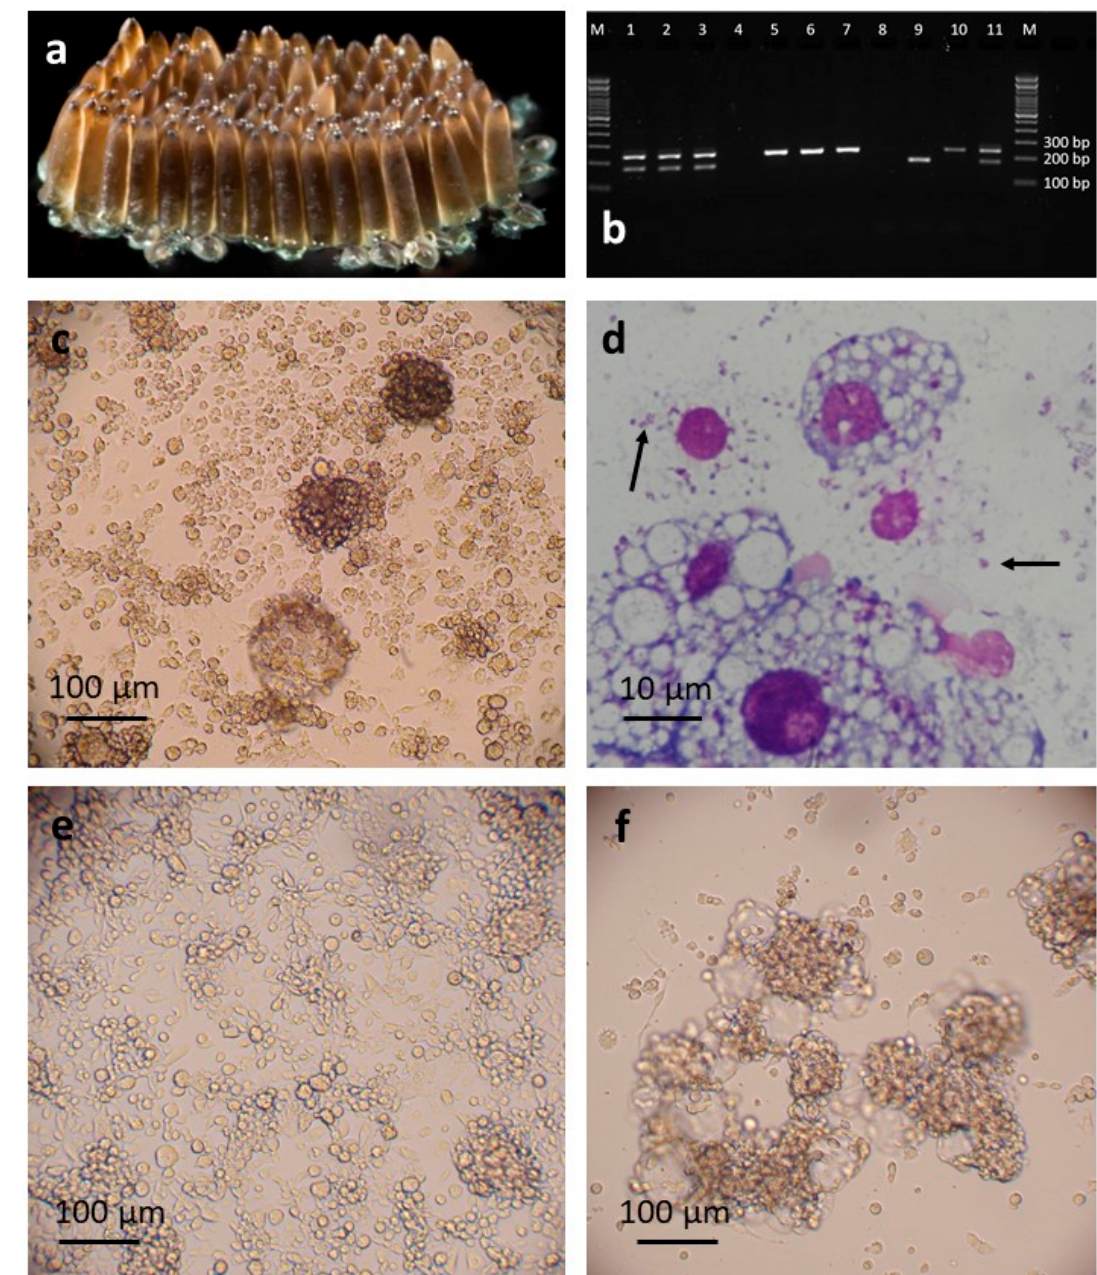
Figure 1 . Culex pipiens cell lines CPE/LULS50 and CPL/LULS56. ( a ) C. pipiens eggs. ( b ) Agarose gel electrophoresis of CQ11 microsatellite locus PCR products obtained from DNA extracted from CPE/LULS50 cells (lanes 1-3), CPL/LULS56 (lanes 5-7), Culex pipiens pipiens mosquito (lane 9), Culex pipiens molestus mosquito (lane 10), C. p. pipiens and C. p. molestus hybrid (lane 11); negative controls are in lanes 4 and 8. ( c ) CPE/LULS50 cells at passage 1, 6 months after initiation, live, inverted microscope. ( d ) CPE/LULS50 cells showing Wolbachia bacteria inside cells and extracellularly (arrows); Giemsa-stained cytocentrifuge smear. ( e ) CPE/LULS50 cells at passage 18, 17 months after initiation; live, inverted microscope. ( f ) CPL/LULS56 cells at passage 5, 17 months after initiation; live, inverted microscope.